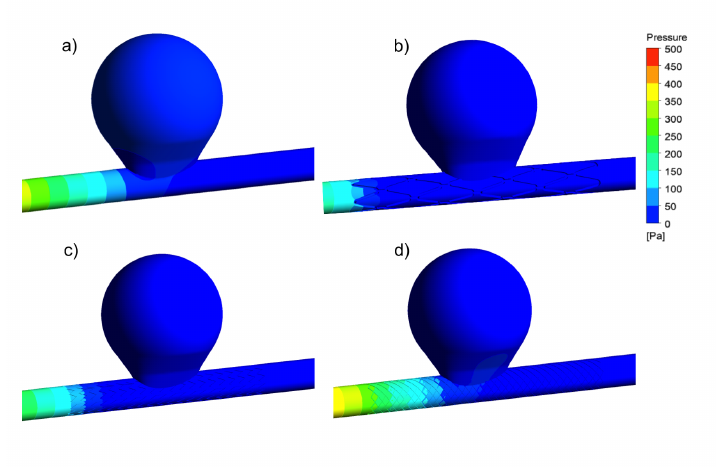
Figure 5. Pressure contours for the cases of ( a ) control case, ( b ) STENT BS, ( c ) STENT 1, and ( d ) STENT